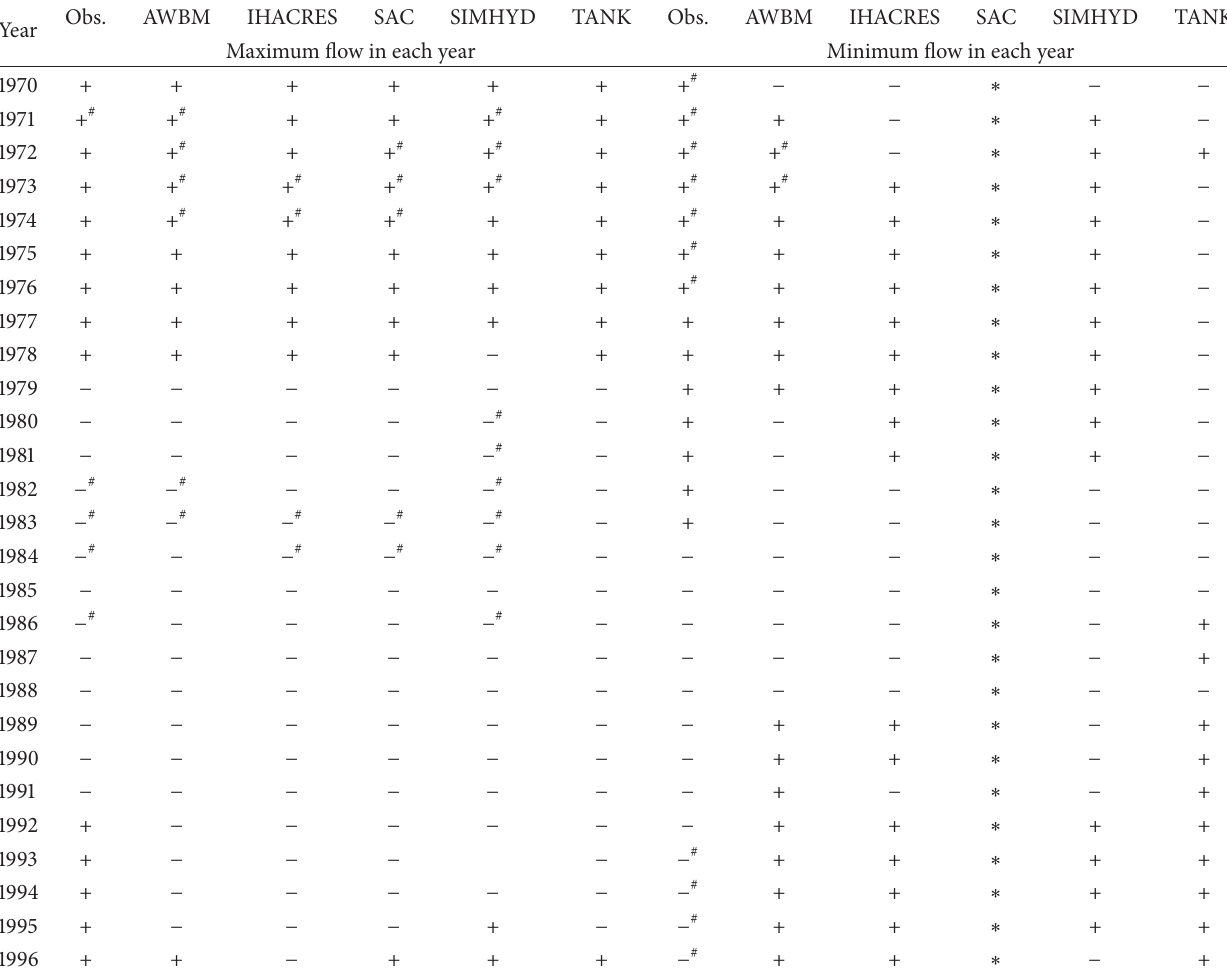
The symbols “+” and “ − ” denote anomaly greater and less than zero, respectively. The symbol “ ∗ ” indicates anomaly of zero percent. “Obs.” denotes observed change. The cells with superscript symbol “#” are for anomalies significant at the level of 5 % . Each anomaly was placed at the center of the 10-year time slice, for example, 1965–1974, 1966–1975 ,... , 1991–2000, obtained based on the NAIM procedure as described in Section